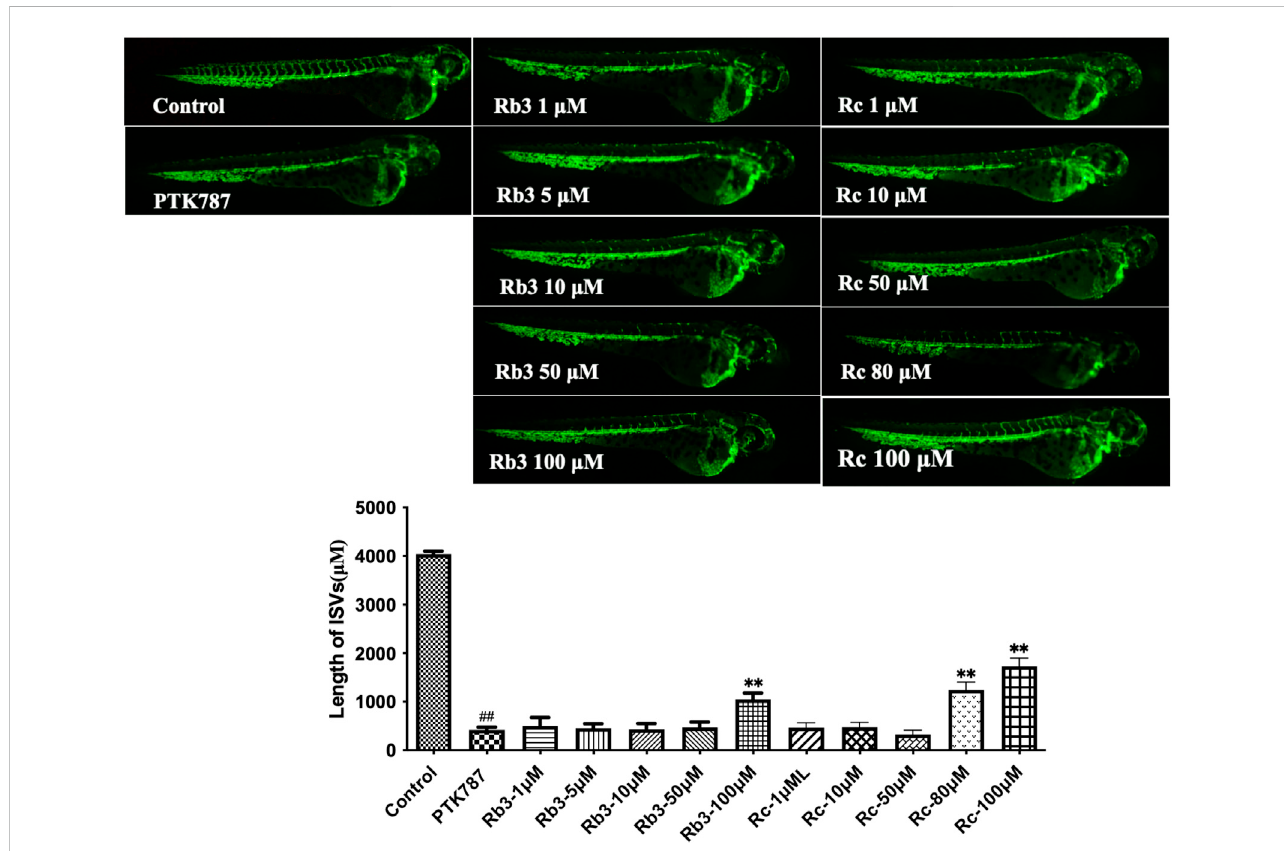
FIGURE 10 Ginsenosides Rb3 and Rc stimulated angiogenesis in a zebra fi sh model. Lateral view of zebra fi sh embryos treated with DMSO (0.1%, Control), PTK787 (0.2 μ g/mL), PTK787 plusginsenoside Rb3 (1, 5,10,50, and100 μ g/mL) or Rc (1,10,50, 80,and 100 μ g/mL) for 24 hRb3 (100 μ g/mL) and Rc (80and 100 μ g/ mL) restored angiogenesis in ISVs against PTK787-induced impairment. Quanti fi cation of total length of ISVs in different groups from three independent experiments. Statistical analysis data were shown as mean ± SEM ( n ≥ 4). The comparison between groups was performed by student ’ s test. ## p < 0.01 versus Control group; ** p < 0.01 versus PTK787-treated